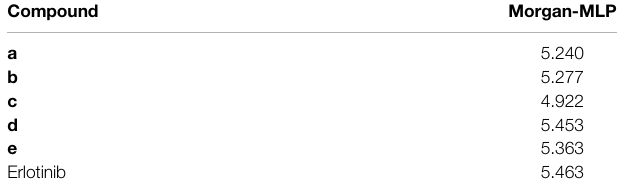
TABLE 2 | Af fi nity prediction results of the designed molecules. Compound